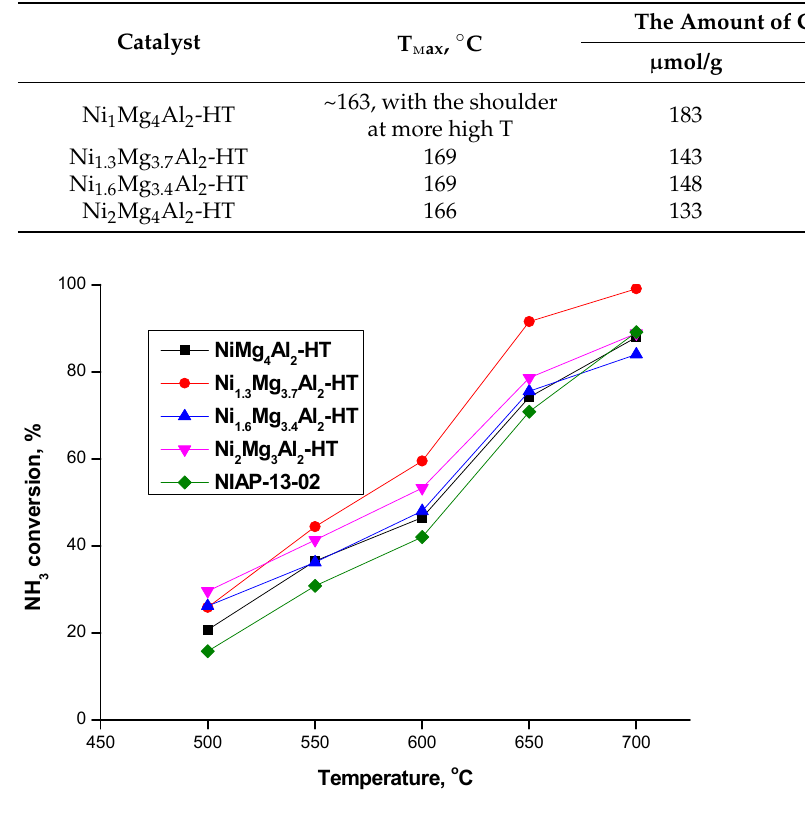
Figure 5. The influence of the reaction temperature on NH 3 conversion over Ni x Mg y Al 2 -HT catalysts (700 °C, H 2 ) (GHSV 72,000 h − 1 ). Table 3. Comparison of the NH 3 decomposition activity of nickel based catalysts (700 °C, H 2 ). Catalyst Ni Content wt.%